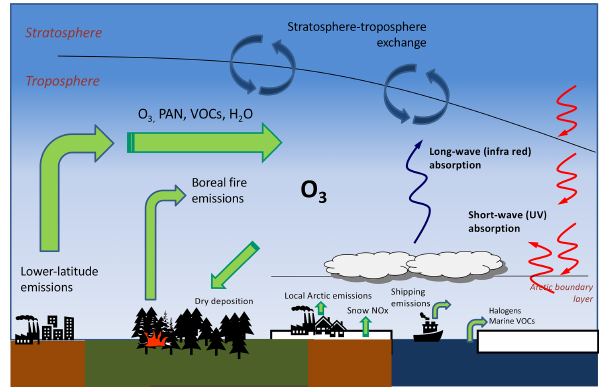
Figure 1. Schematic of Arctic tropospheric O 3 sources, sinks, and relevant